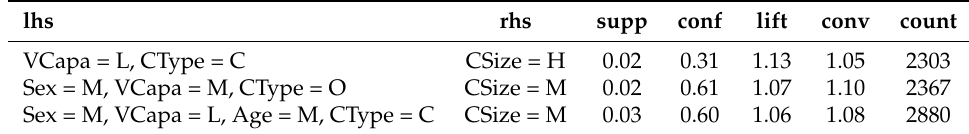
Table 5. Association rules for claim size based on policy